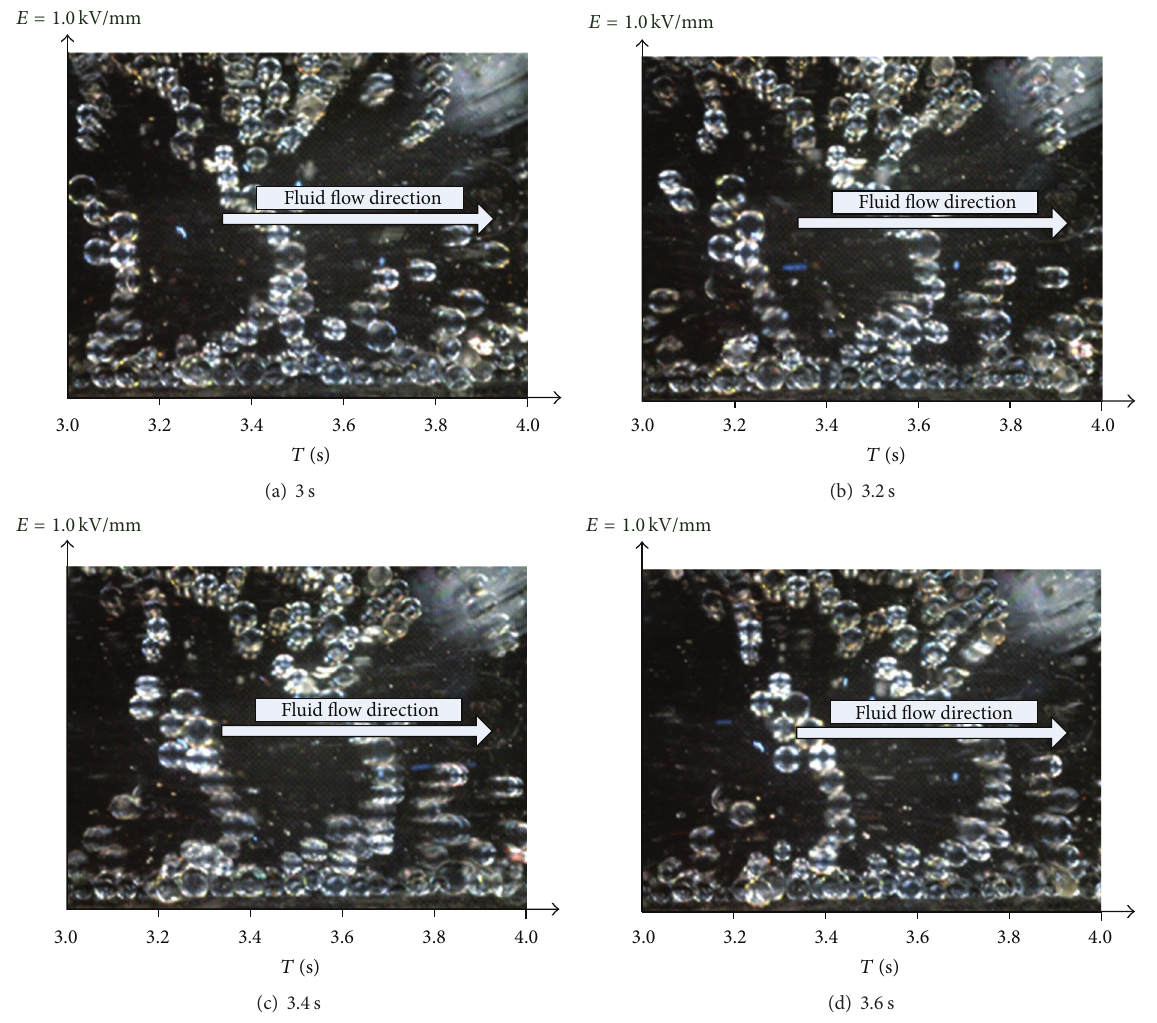
Figure 5: Boundary slip of ER fluids in dynamic